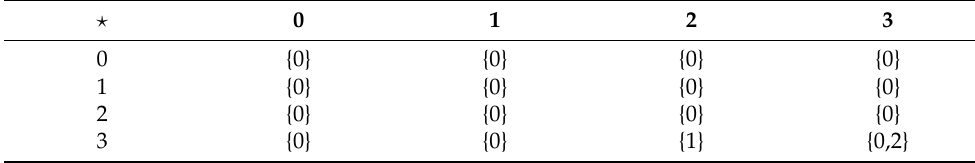
Table 1. The binary hyperoperation (cid:63) on C .